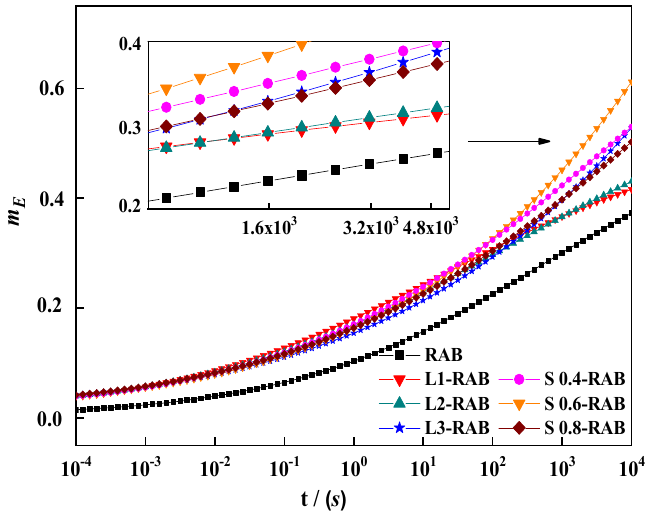
Figure 8. The master curves of 𝑚 (cid:3006) for W-RABs at a reference temperature of − 12 ℃ .